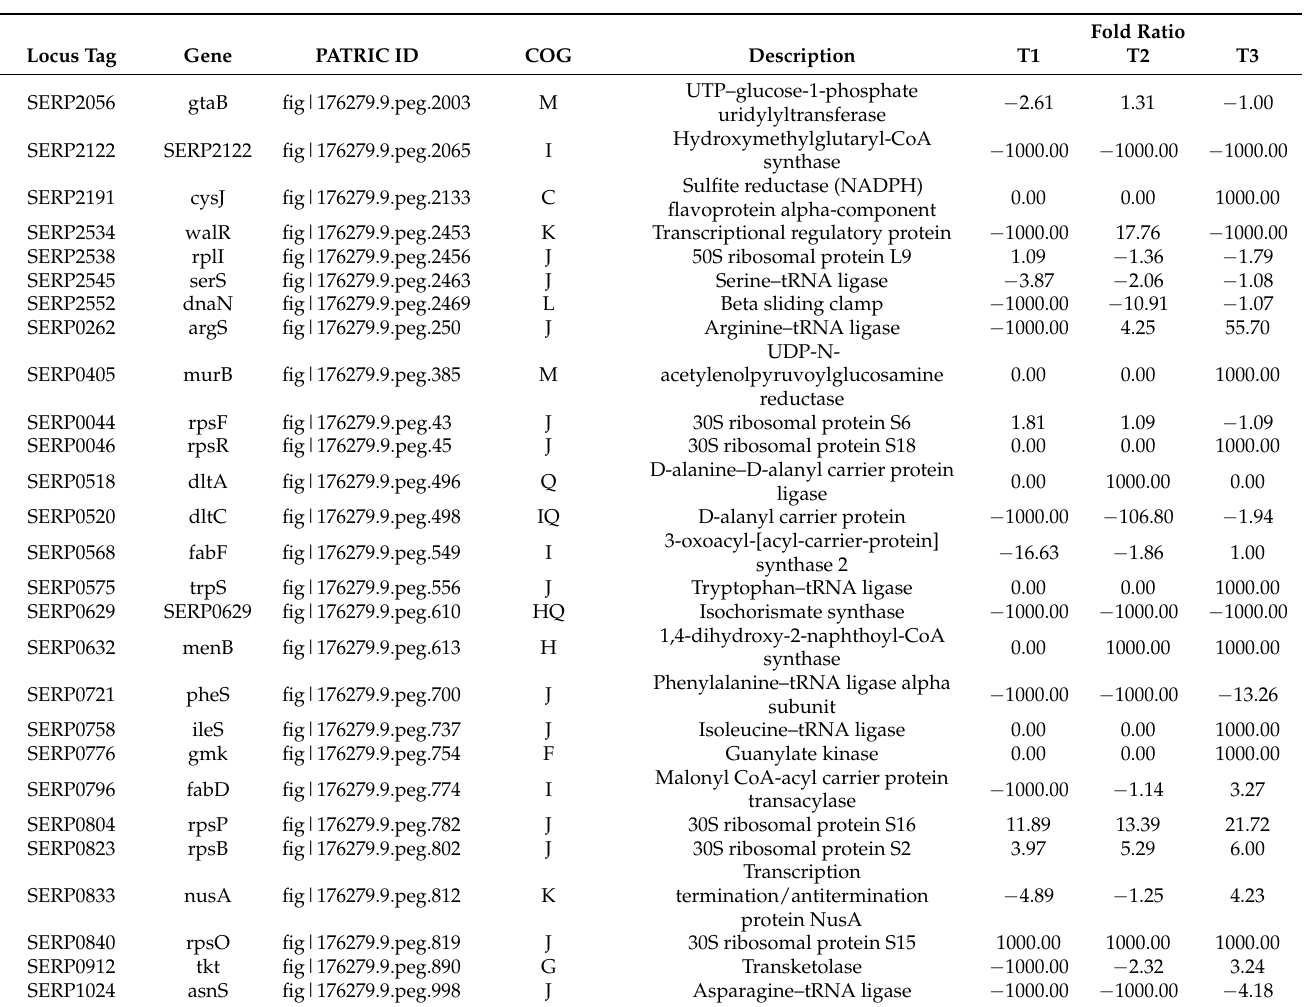
fig|176279.9.peg.890